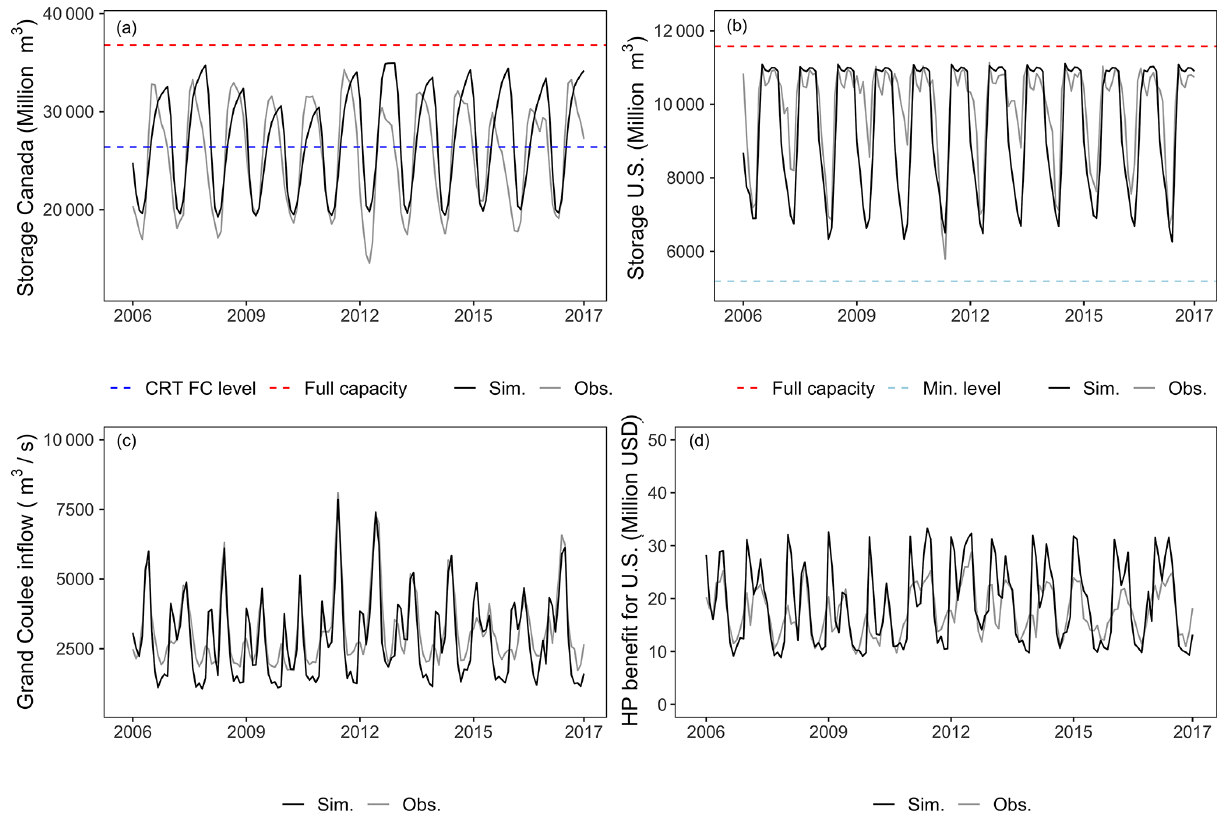
Figure 6. Validation result 2006–2017 showing (a) Canadian storage, (b) US storage, (c) Grand Coulee inflow, and (d) hydropower benefit for the United States. Note that sim. – simulated, obs. – observed, full capacity – maximum capacity, CRT FC level – CRT flood protection target level, and min. level – minimum capacity for the US